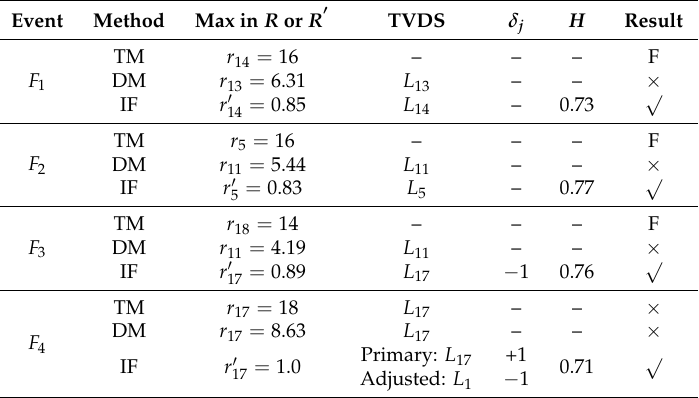
Table 4. Location Result of Different Methods.